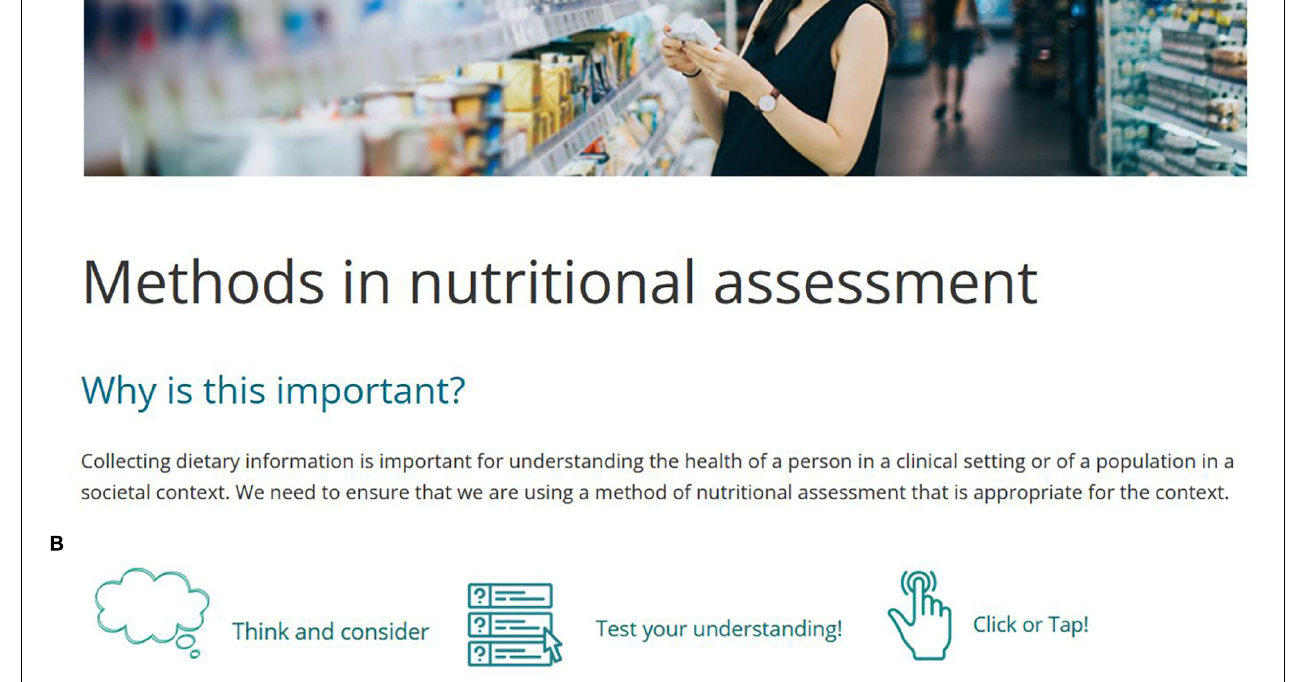
FIGURE 3 | Example of visually rich manner information presented in the online interactive topic guides, with images (A) and symbols (B) used to signpost sections of content and activities. Screenshots © Deakin University. All Rights reserved. Reproduced with permission by Deakin University. Stock images © Getty Images. Originally reproduced under licence and within this article by permission